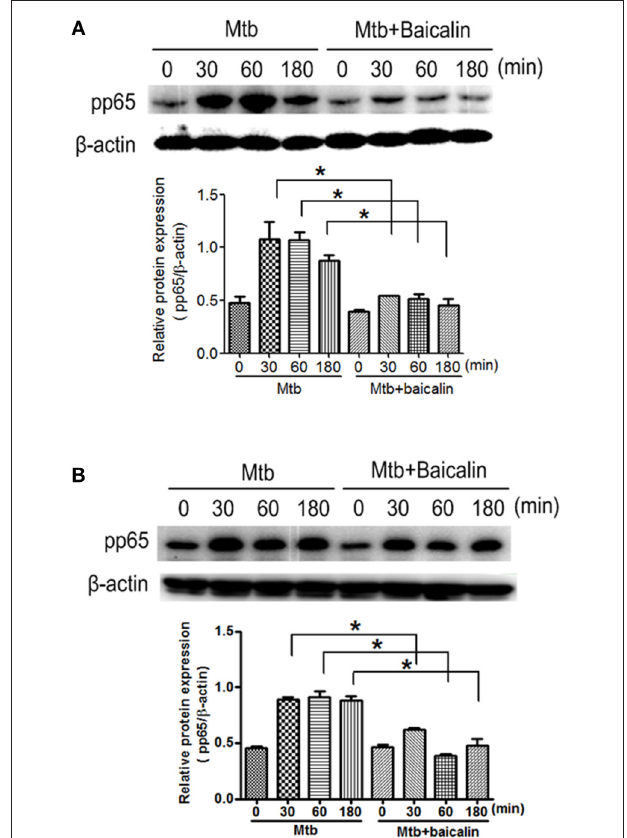
FIGURE 9 | Baicalin inhibits Mtb-induced NF- κ B activation. (A) Western blot analysis of p-p65 expression in Raw264.7 cells. β -actin was used as a loading control. The below bar graph shows the statistical result for the relative quantitative expression of p-p65. (B) Western blot analysis of p-p65 expression in primary peritoneal macrophage cells. β -actin was used as a loading control. The below bar graph shows the statistical result for the relative quantitative expression of p-p65. Data are shown as the means ± SD of at least three independent experiments. * p < 0.05.